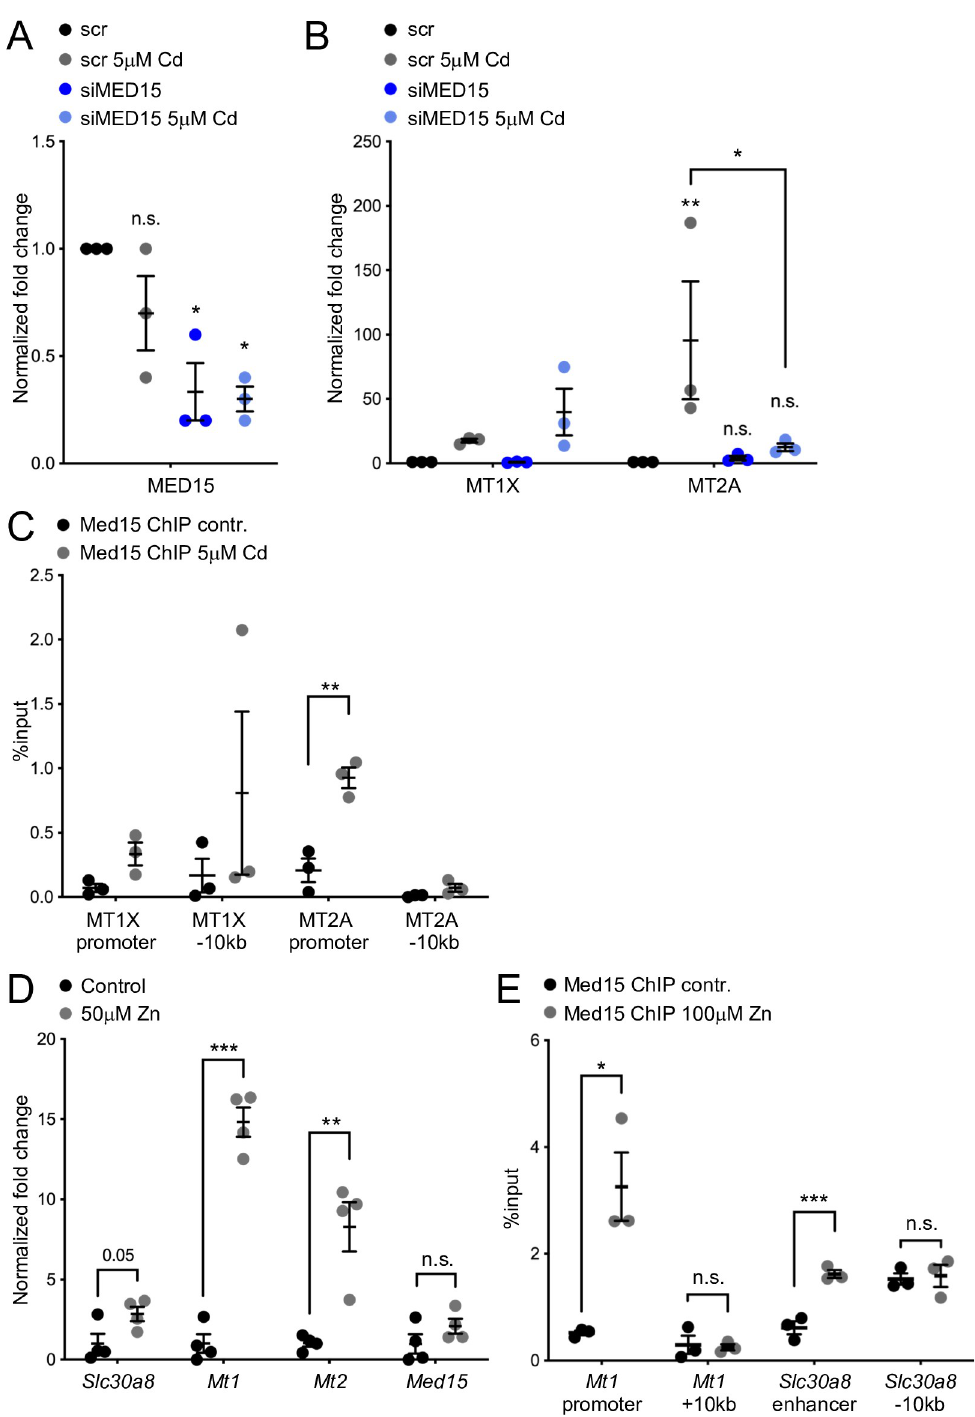
Fig 7. MED15 binds and regulates cadmium and zinc responsive genes in mammalian cells. [A] qRT-PCR analysis of MED15 mRNA in control (scr = scrambled siRNA) and MED15 siRNA (siMED15) treated A549 cells exposed to 5 μ M cadmium for four hours. Error bars: SEM; statistical analysis: � p < 0.05, One-way ANOVA, multiple comparison, Tukey correction, all comparisons to “scr” (n = 3 independent repeats). [B] qRT-PCR analysis of cadmium inducible genes in control (scr = scrambled siRNA) and MED15 siRNA (siMED15) treated A549 cells exposed to 5 μ M cadmium for four hours. Error bars: SEM; statistical analysis: � p < 0.05, �� p < 0.01, Two-way ANOVA, multiple comparisons, Tukey correction (n = 3 independent repeats). MT1X expression was not significantly affected. For MT2A, all comparisons